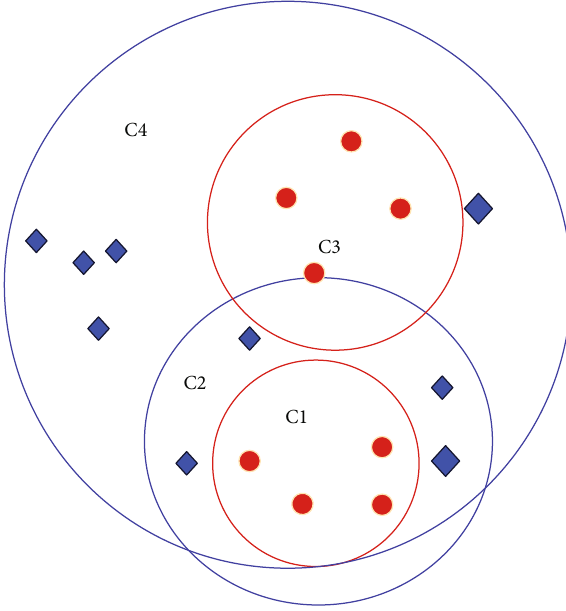
Figure 3: Classi fi cation results of the crosscopula